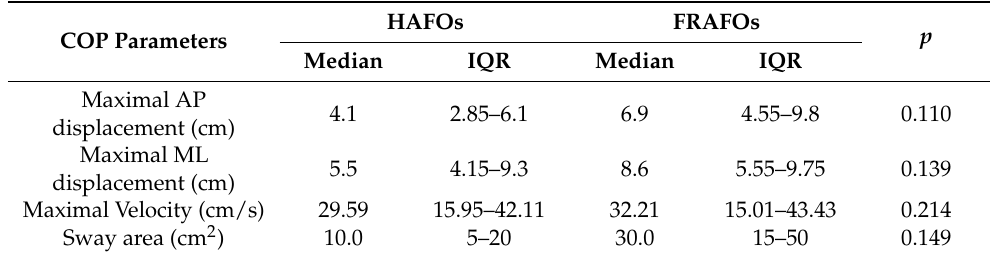
Table 2. Comparison of the center of pressure (COP) parameters during static standing between participants wearing HAFOs and FRAFOs.